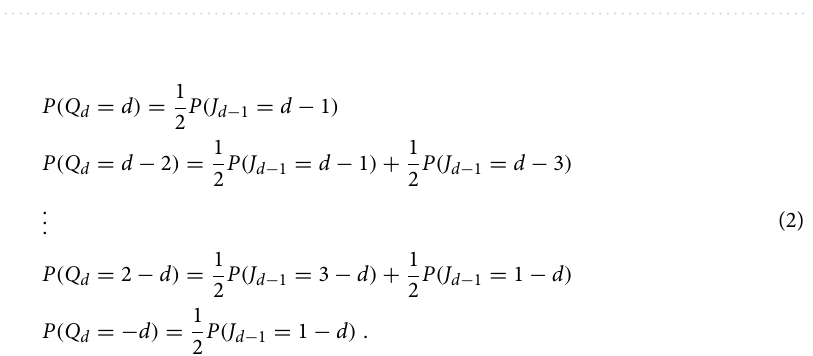
Figure 4. Value V d , b of playing a tree of depth d and branching factor b with exhaustive sampling. ( a ) The value (expected cumulative reward) of playing a tree increases monotonically with both its depth d and its branching factor b . In all cases p = 1 2 . For b = 5 (pink) the value is very close to the maximum possible value (dashed, diagonal line). ( b ) The value of playing the tree grows with the probability p of high expected reward in their nodes. In all cases b = 2 . In both panels, lines correspond to analytical predictions from the diffusion- maximization method, Eqs. (2,3) and Eqs. (15,16,23,24) (Sect. “Value of exhaustive or selective search in a large tree with rational p ” of the Methods), and dots correspond to Bellman - Monte Carlo simulations (see Sect. “Bellman–Monte Carlo simulations” of the Methods; average over 10 4 runs). The red lines in the two panels are identical. Errors bars are smaller than